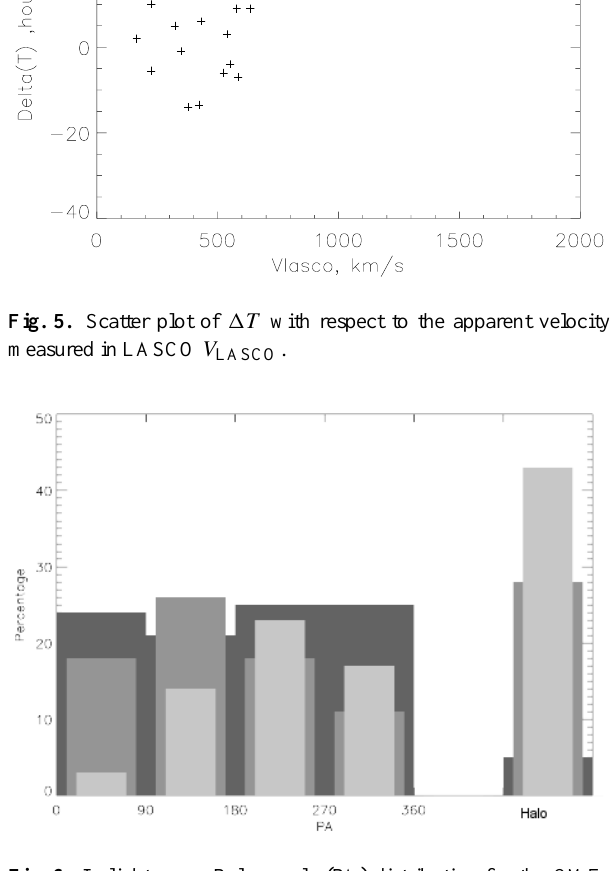
Fig. 6. In light grey: Polar angle (PA) distribution for the CMEs identified in column 7 of Table 1. In dark grey: same histogram for the CMEs identified in column 6 of Table 1. In black: same histogram for all the CMEs identified in LASCO during the same